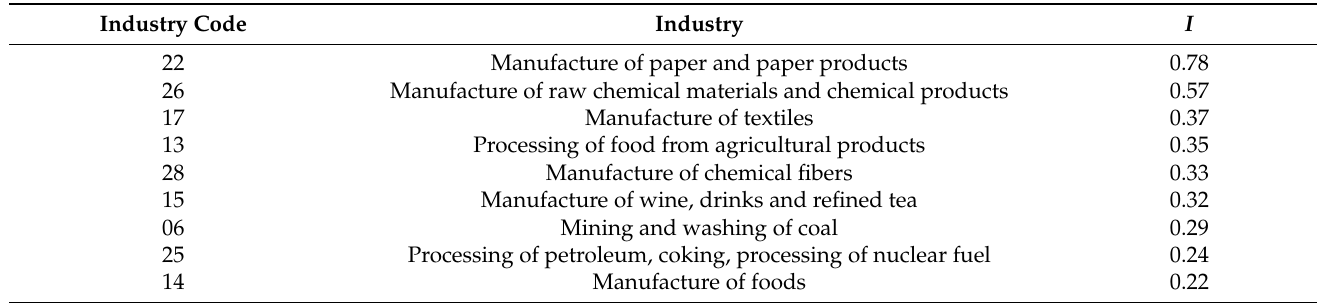
Table 1. Water pollution-intensive index of